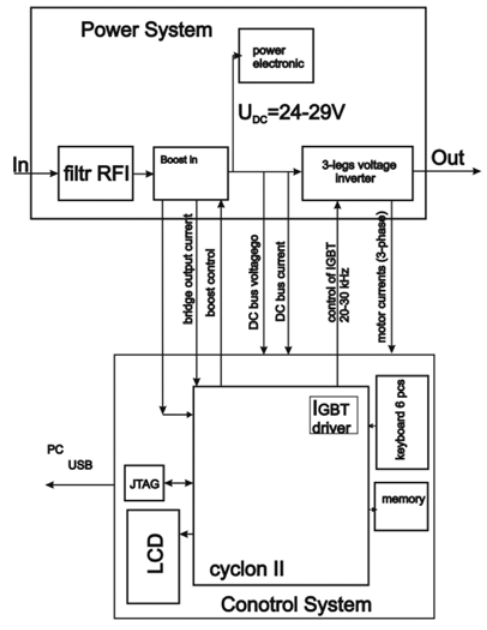
Fig. 1. Block diagram of the BLDC converter